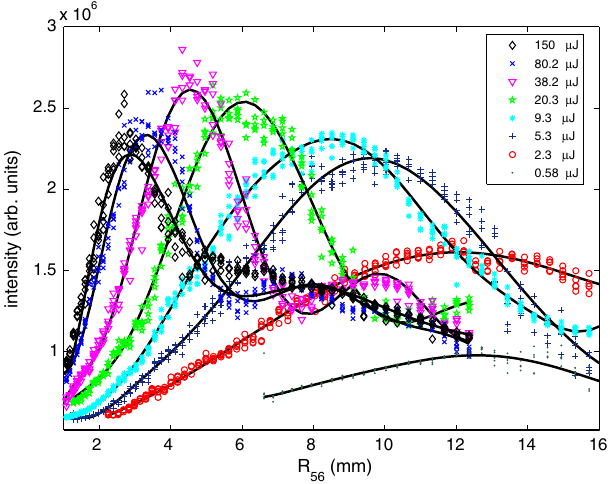
FIG. 9. Experimental data and fitted curves for various values of seed laser energy. The radiation intensity was recorded by a CCD when scanning the DS strength. The energy of the seed laser is changed from 0.58 to 150 (cid:5) J . Different symbols stand for different seed laser energies; the black lines are the fitted lines for different symbols.